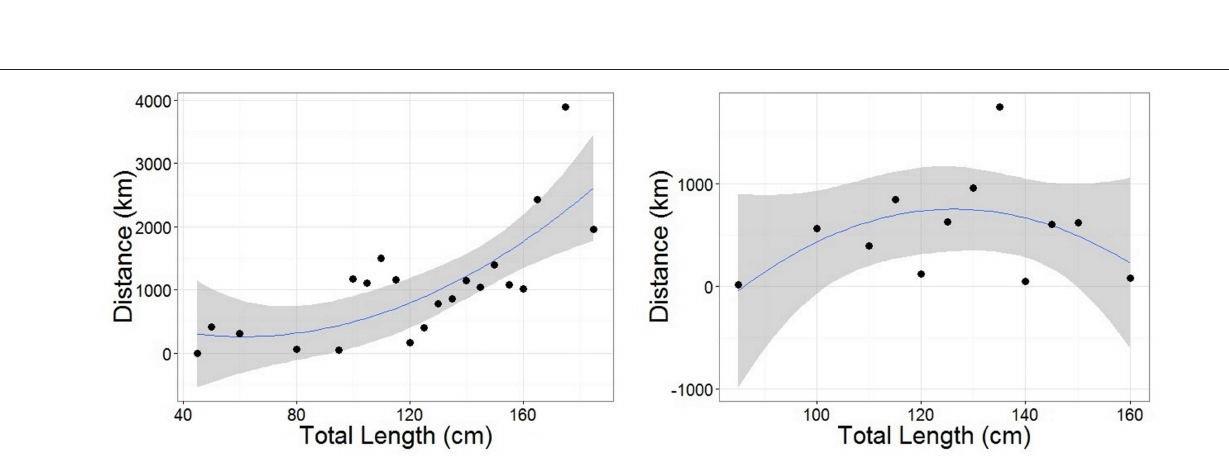
Frontiers in Ecology and Evolution |